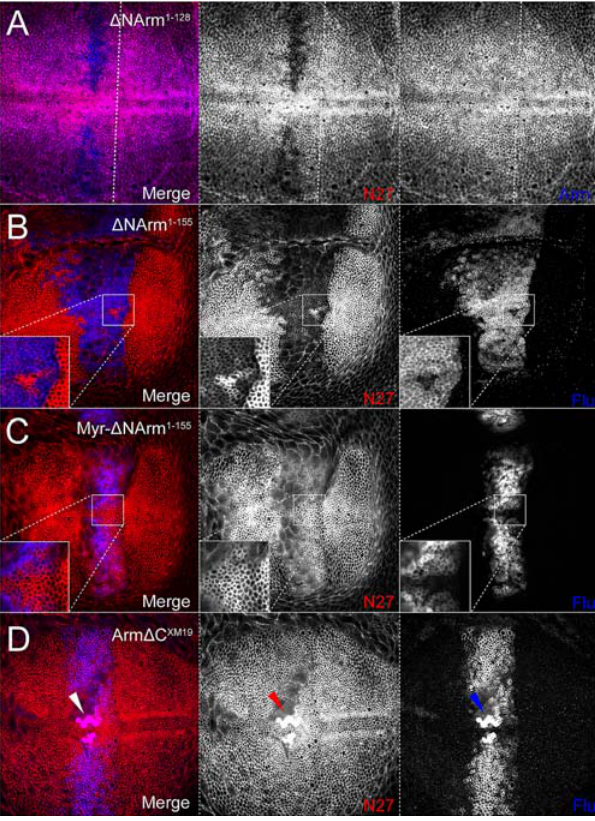
Figure 7. Arm S10 induced signalling correlates with clearing of endogenous Armadillo from the AJ and dynamic regulation of subcellular distribution subapically. (A) Similarly to Wingless ligand-dependent signalling, Arm S10 does not affect the distribution of E-Cadherin-GFP (E-CadGFP) in the AJ. (B) In contrast, Arm S10 entirely displaces endogenous Armadillo from the AJ, which can often be identified as puncta immediately subapically (red channel, inset). (C) E- Cadherin-GFP (E-CadGFP) accumulates in puncta upon Arm S10 over- pexression similarly to ligand-dependent signalling. (D) In contrast, Arm S10 causes an accumulation of endogenous Armadillo to high levels in the centre of the dppGAL4 overexpression domain, but results in complete loss from the cytoplasm and basolateral membrane at the edges (red arrows). the ‘‘N27’’ (N-terminal, N27A1) and the ‘‘Arm’’ (central Armadillo repeats) antibodies, as the latter will identify both endogenous and overexpressed proteins (Figure 1). Compared to Arm S10 , D NArm 1–128 was found to be stable only in the central domain of dppGAL4 expression, several cell diameters from the A/P boundary (Figure 8), where it inefficiently excluded the endoge- nous protein. In contrast, the Flu-tagged D NArm 1–155 construct, which also lacks part of the 1 st Armadillo repeat (Figure 1), was found to be highly stable across the entire domain of dppGAL4 expression (central and lateral), competing with the endogenous Armadillo up to the A/P boundary (Figure 8B), but not entirely excluding it from the AJ (compare insets red and blue channels), contrasting with the efficient exclusion caused by Arm S10 . However, its distribution extended further anteriorly, particularly in the dorsal compartment (compare to Figure 7A and B). In contrast, the membrane targeted form Myr- D NArm 1–155 was expressed in a similar domain as Arm S10 , but was unable to exclude the endogenous protein from the AJ (Figure 8C, insets).